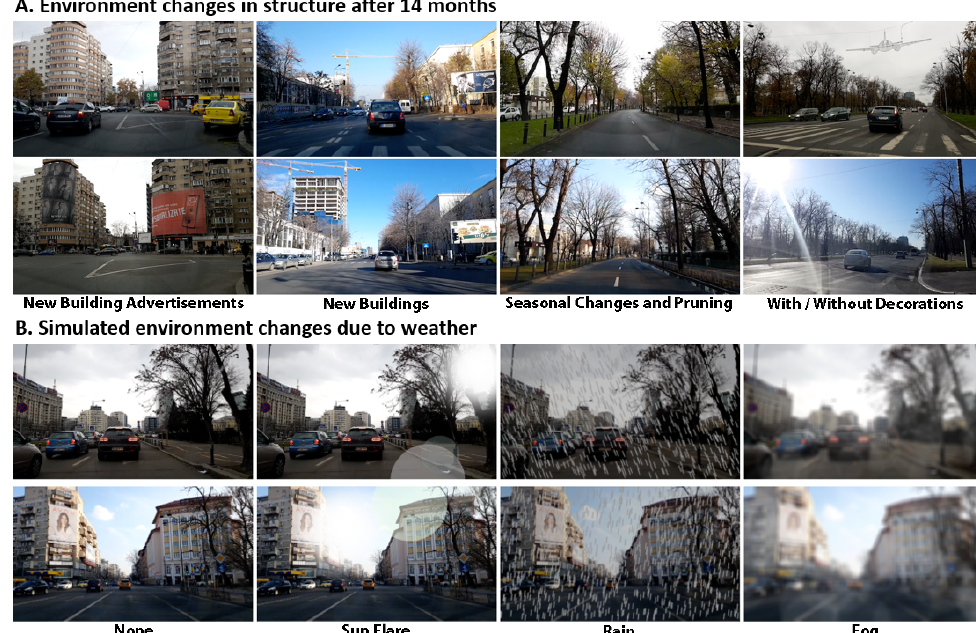
Figure 8. Examples of changes in environmental conditions. ( A ) Long-term structural changes. ( B ) Short-term changes in weather (artificially